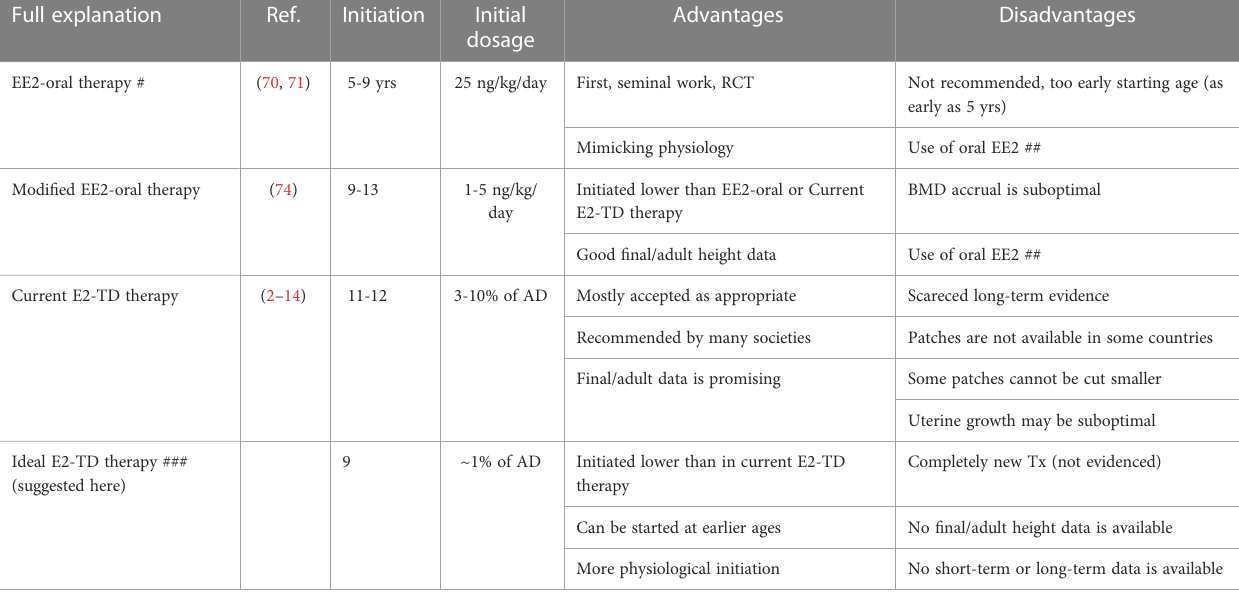
TABLE 4 Advantages and disadvantages of EE2-O therapy, modi fi ed EE2-O therapy, current E2-TD therapy, and ideal E2-TD therapy. Full explanation